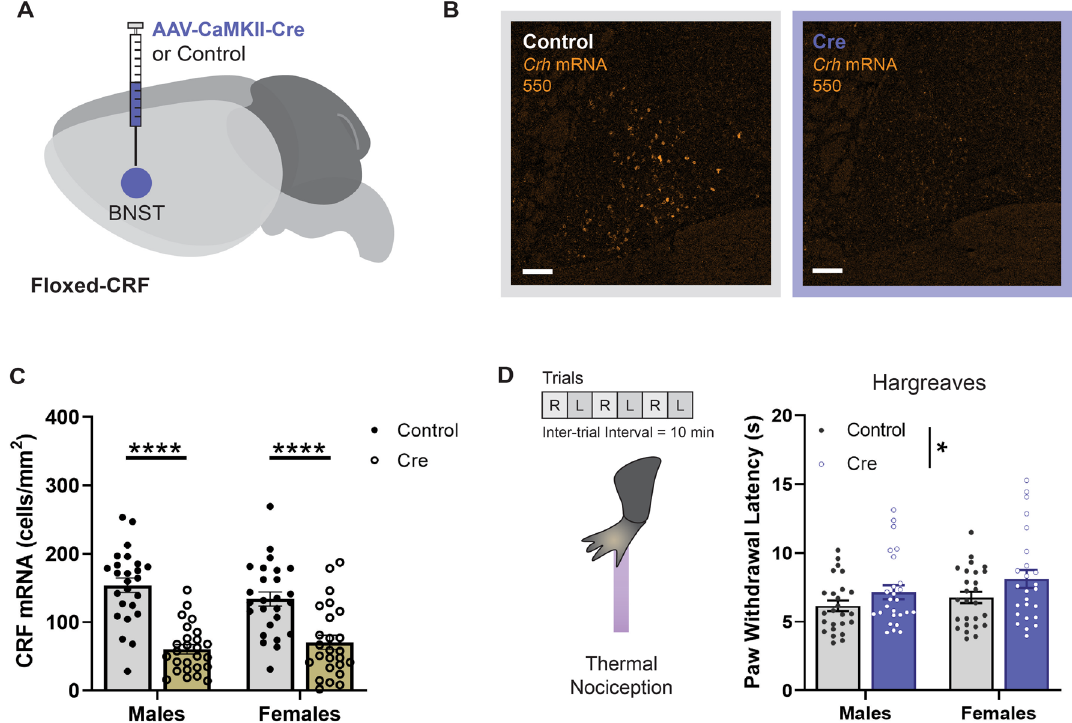
Figure 5. CRF Deletion in BNST Reduces Thermal Nociceptive Sensitivity. ( A ) Diagram of Cre-dependent approach for CRF deletion in BNST. ( B ) Representative histology of CRF mRNA expression in BNST of Floxed-CRF mice following virus infusion. ( C ) Quantification of CRF mRNA expression in BNST of male (n = 25–26) and female (n = 25–26) subjects by cells/mm 2 (Two-way ANOVA with Tukey’s post hoc: no Sex × Virus interaction [F(1, 98) = 2.548, P = 0.1136] or main effect of Sex [F(1, 98) = 0.2667, P = 0.6067]; main effect of Virus [F(1, 98) = 66.74, P < 0.0001]). ( D ) (Left) Schematic of the Hargreaves test. Each paw was assessed using three replicate exposures, alternating between the right (R) and left (L) limb, resulting in six trials total. (Right) Thermal nociceptive sensitivity of male (n = 25–26) and female (n = 25–26) subjects (Two-way ANOVA with Tukey’s post hoc: no Sex × Virus interaction [F(1, 98) = 0.1253, P = 0.7242] or main effect of Sex [F(1, 98) = 2.471, P = 0.1192]; main effect of Virus [F(1, 98) = 5.388, P = 0.0223]). Data are shown as mean ± SEM. * P <